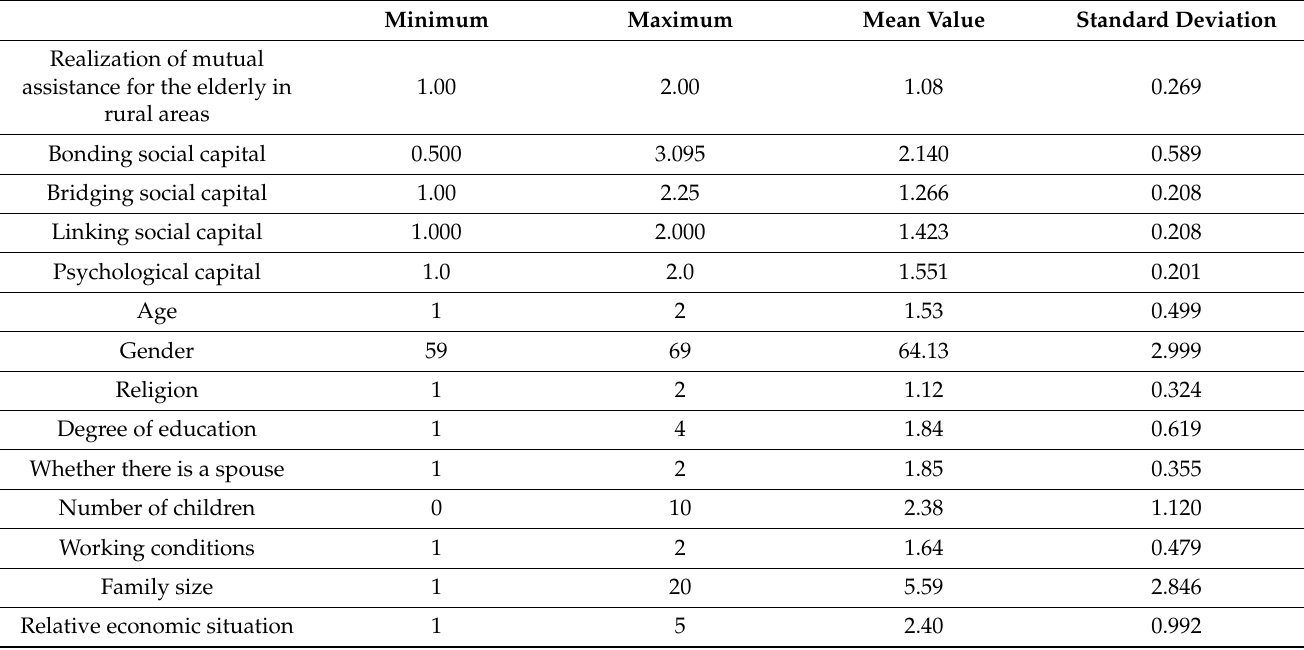
Table 3. Descriptive statistical results of